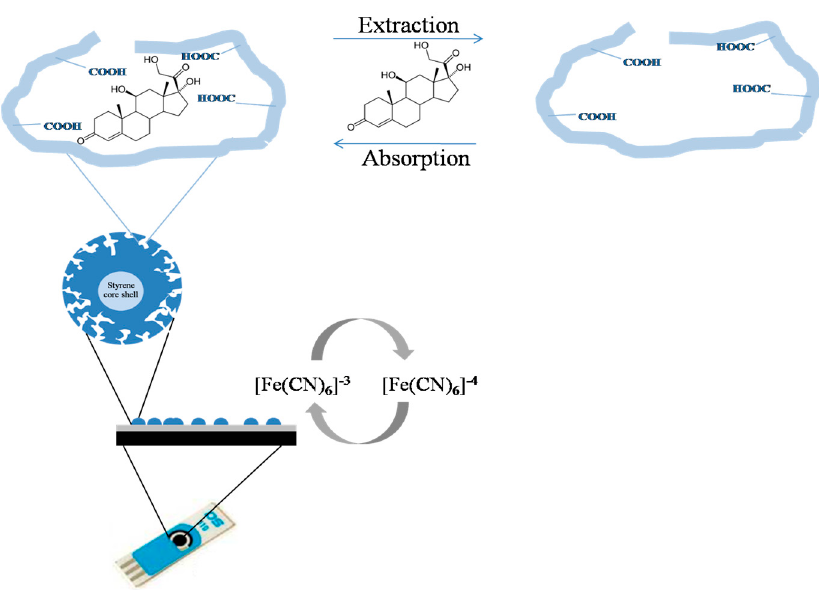
Figure 1. Schematic illustration of MIP particles modified screen printed carbon electrode detecting